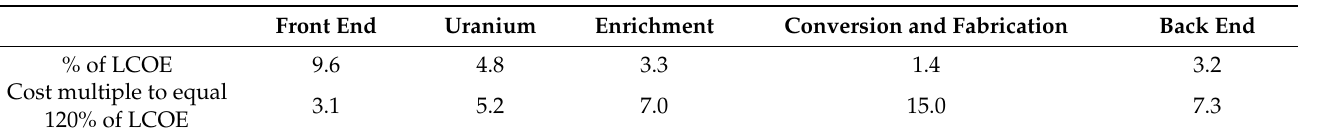
Table 3. Changes in fuel cycle costs needed to cause a +20% increase in LCOE (assuming 7% discount rate) [46].